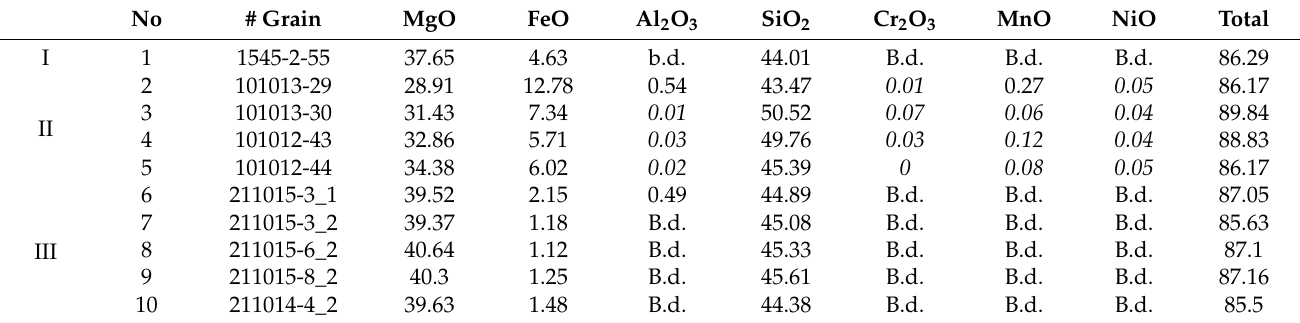
Table 7. Chemical composition of serpentine in clinopyroxenites I–III (in wt.%).